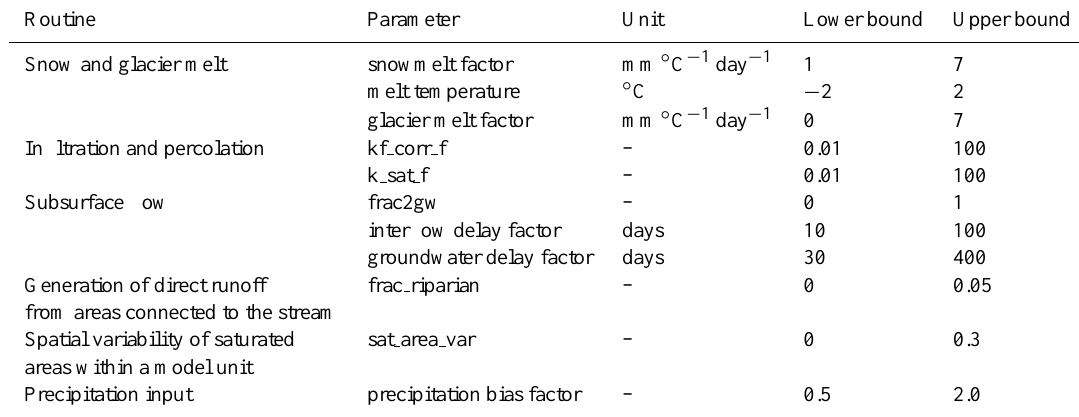
Table 3. Calibration parameters including values for the lower and upper